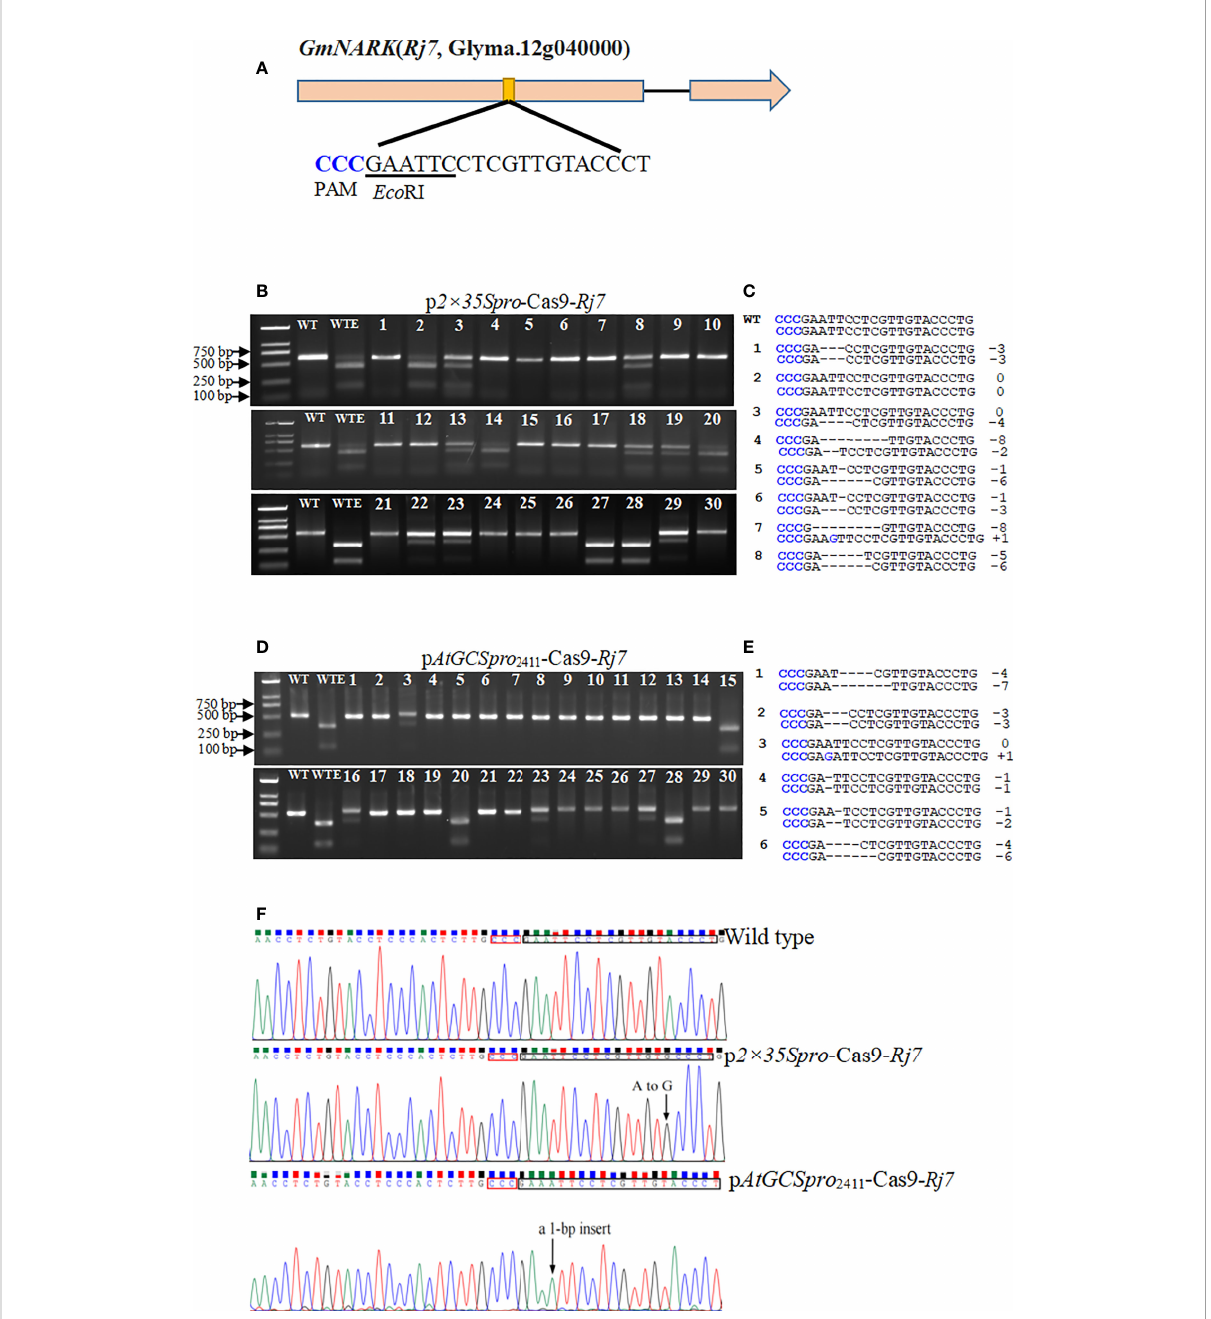
FIGURE 5 Identi fi cation of CRISPR/Cas9-induced mutation in the GmNARK ( Rj7 ) target loci in soybean with AtGCSpro 2411 and 2×35S to drive Cas9 , respectively. The sequence of an sgRNA designed to target a site within the fi rst exon region of Rj7. The protospacer-adjacent motif (PAM) sequence is highlighted in blue and the Eco RI restriction site is underlined (A) . PCR-RE assays to detect CRISPR/Cas9-induced mutation in the Rj7 target loci from 30 different independent p 2×35Spro -Cas9 hairy roots (B) . Genotypes of eight representative mutants from transformed with p 2×35Spro -Cas9 hairy roots identi fi ed by sequencing (C) . PCR-RE assays to detect CRISPR/Cas9-induced mutation in the Rj7 target loci from 30 different independent p AtGCSpro 2411 -Cas9 hairy roots (D) . Genotypes of six representative rj7 mutants from transformed with p AtGCSpro 2411 -Cas9 hairy roots identi fi ed by sequencing (E) . In sections B and D, Lanes WT and WTE, undigested PCR ampli fi cation fragment and digested wild-type controls by Eco RI, respectively. Lanes 1 – 30, different independent transgenic hairy roots. In sections C and E, deletions and insertions are indicated as dashes and blue letter, respectively. The types and number(s) of indels are indicated in the right column. Examples given of mutation at target site in the p 2×35Spro -Cas9 and p AtGCSpro 2411 -Cas9 hairy root, respectively (F) . Black arrows indicate the site of indels mutation. The PAM regions and mutated target sites are shown in the black